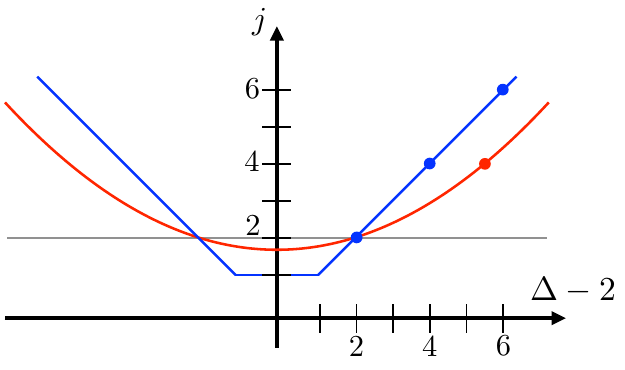
Figure 6 . Schematic representation of the leading Regge trajectory at large N for the example of N = 4 super Yang-Mills at zero (blue), strong (red), and infinite (gray) coupling. In free theory, the Regge trajectory corresponds to the tower of higher-spin conserved currents (blue), with intercept j 0 = 1 . At infinite coupling, the higher-spin currents are lifted to ∆ gap → ∞ , resulting in a flat Regge trajectory (gray) with intercept j 0 = 2